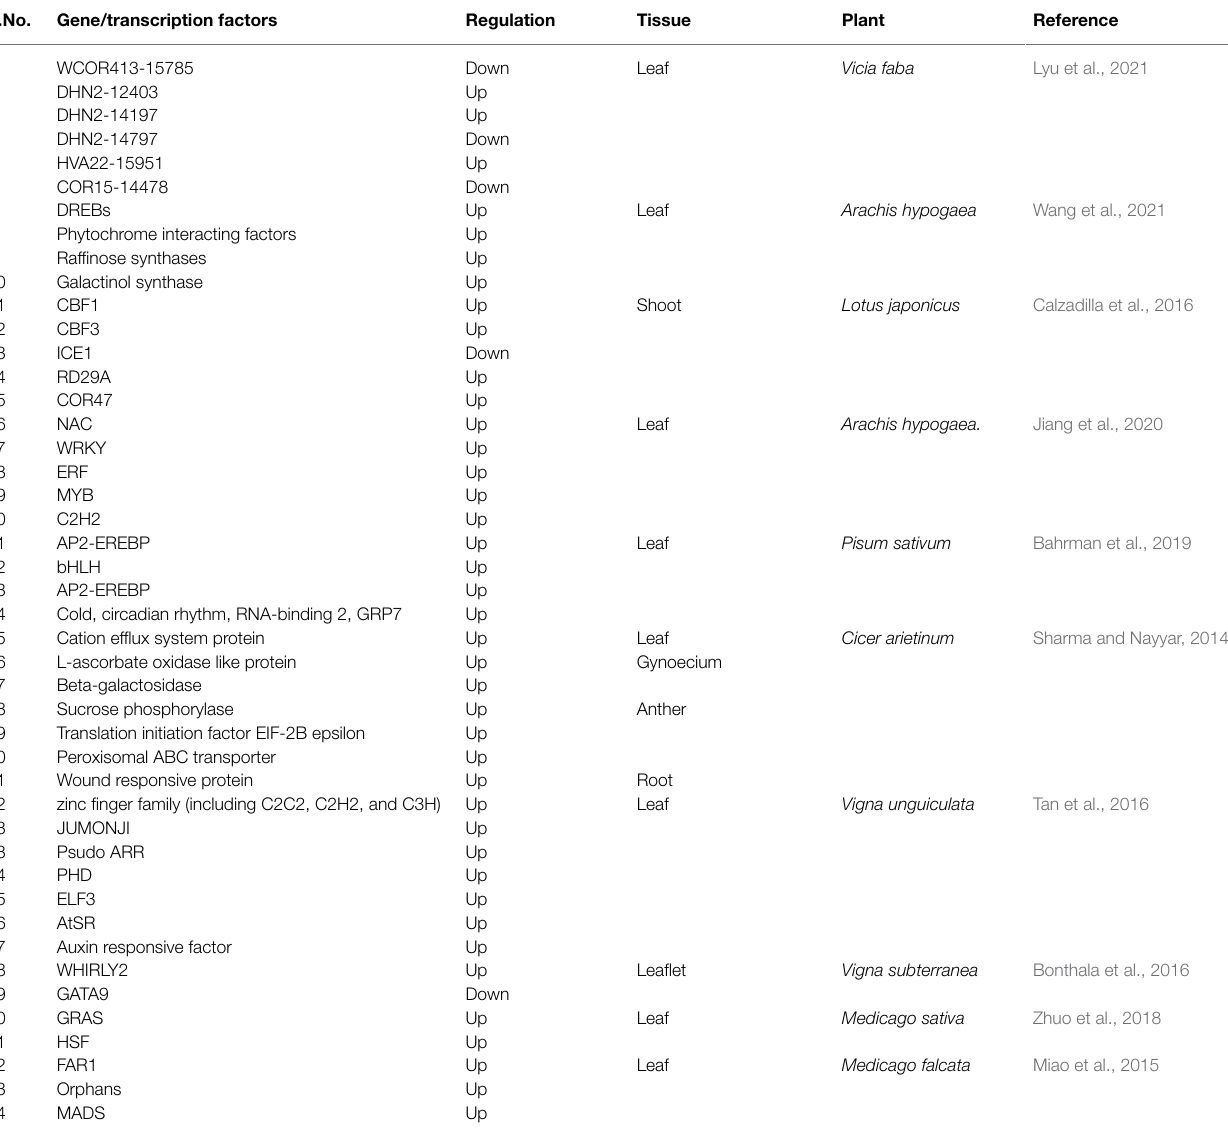
TABLE 3 | Genes/transcription factors identified having role in cold tolerance in different legumes by using RNA seq technology.